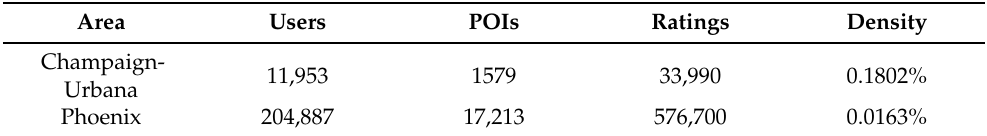
Table 2. Datasets